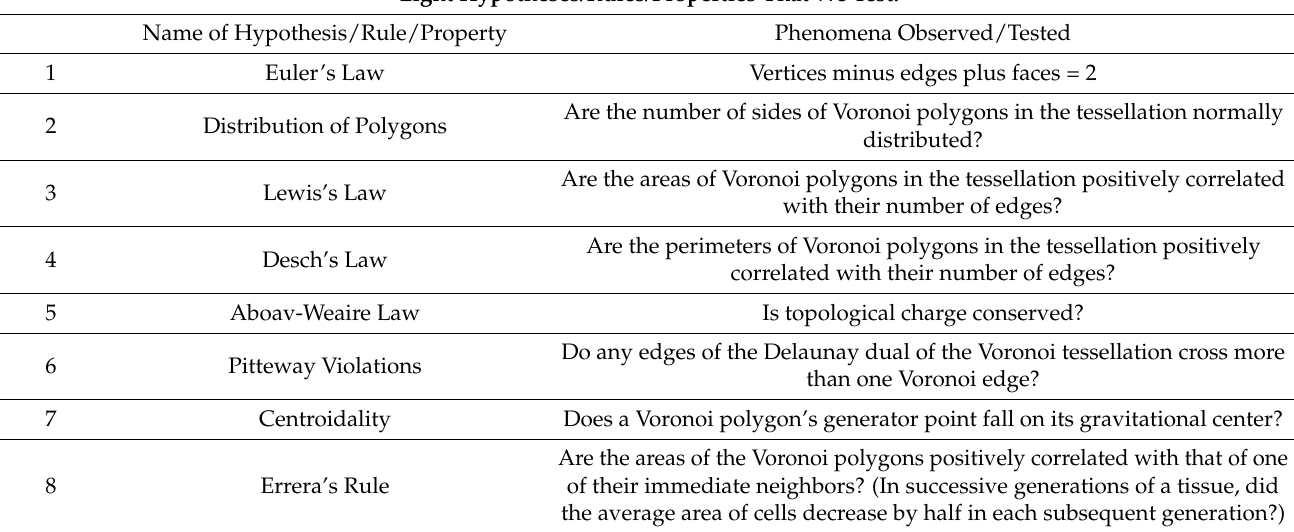
Table 3. Eight analyses of the distribution of the sides per polygon of Voronoi tessellations that widely appear in the biological